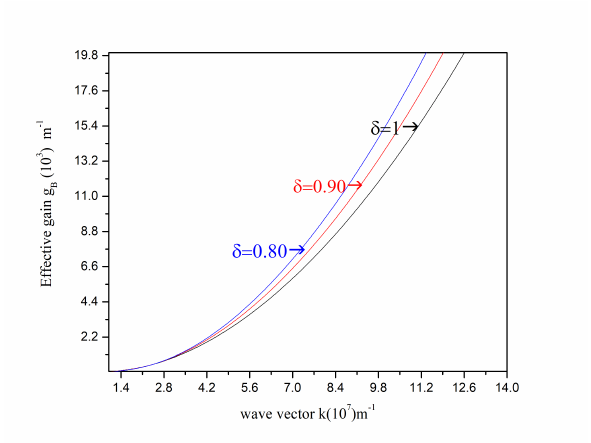
(cid:2) (cid:3) g ef f . with wave number k 0 at E 0 = 5 × 10 7 Vm − 1 and n 0 = 10 26 m − 1 ao